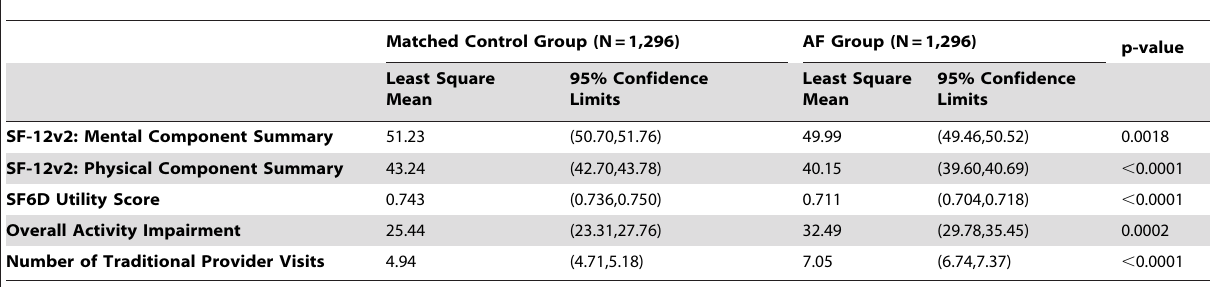
Table 3. Adjusted health outcomes in patients with AF and matched controls.